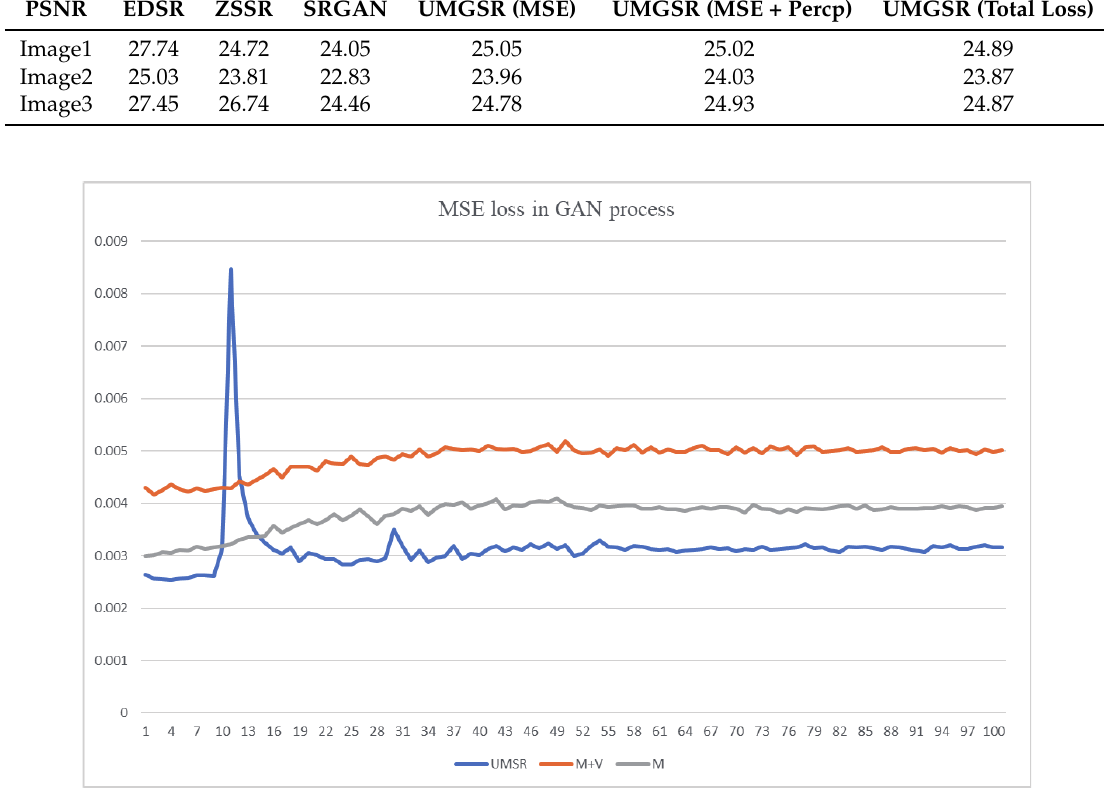
Figure 8. Comparison the MSE error of results with MSE loss (M), MSE and perceptual loss (M+V), and MSE, Perceptual loss and Multi-gram loss